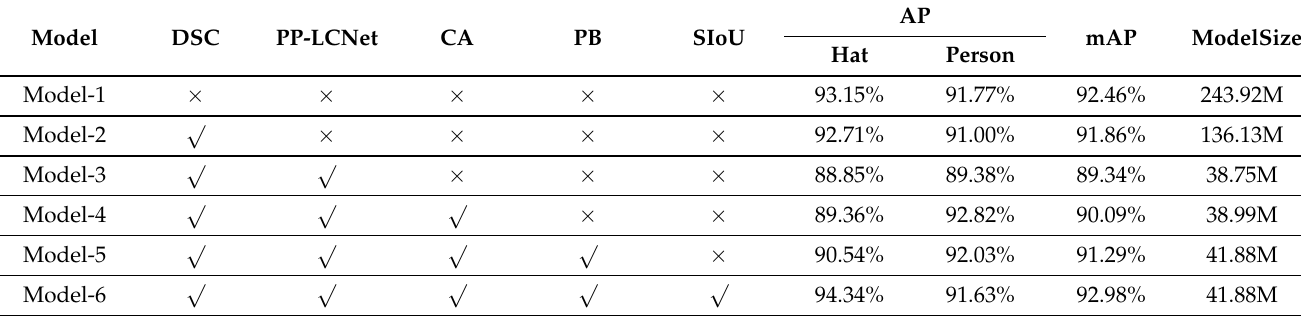
Table 1. Results of ablation